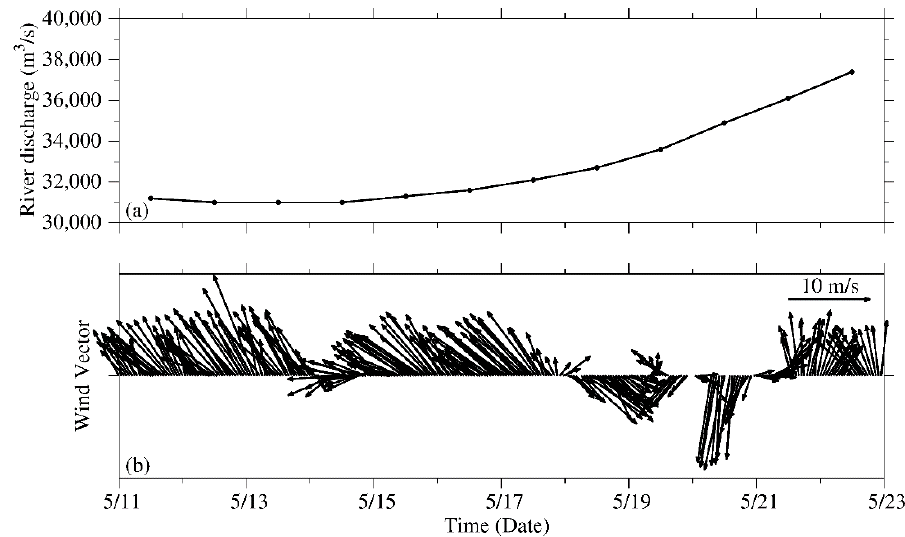
Figure 2. Temporal variation in the measured river discharge at the Datong hydrological station ( a ) and wind vectors at the weather station in the eastern Chongming Sandbank ( b ) from 11 May to 23 May 2019.